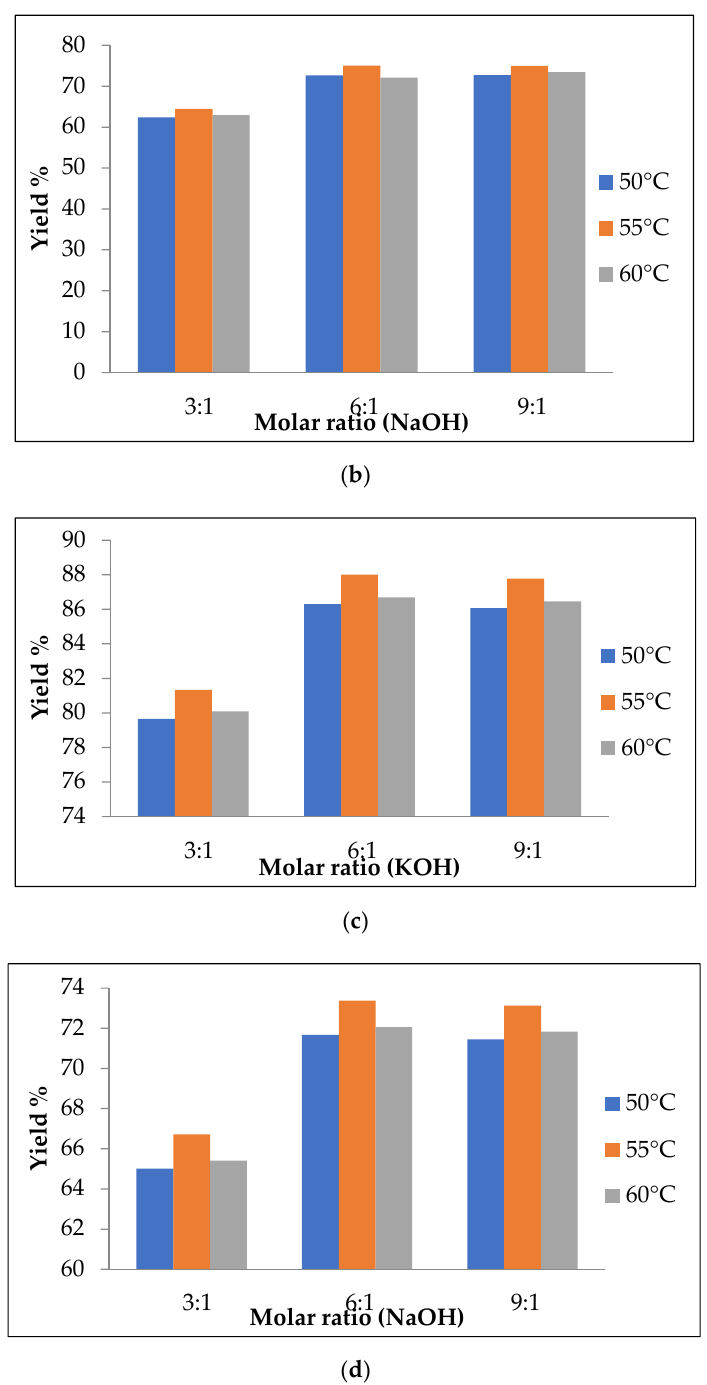
Figure 4. ( a ) Experimental results using the KOH catalyst. ( b ) Experimental results using the NaOH catalyst. ( c ) Modeling results using the KOH catalyst. ( d ) Modeling results using the NaOH catalyst.